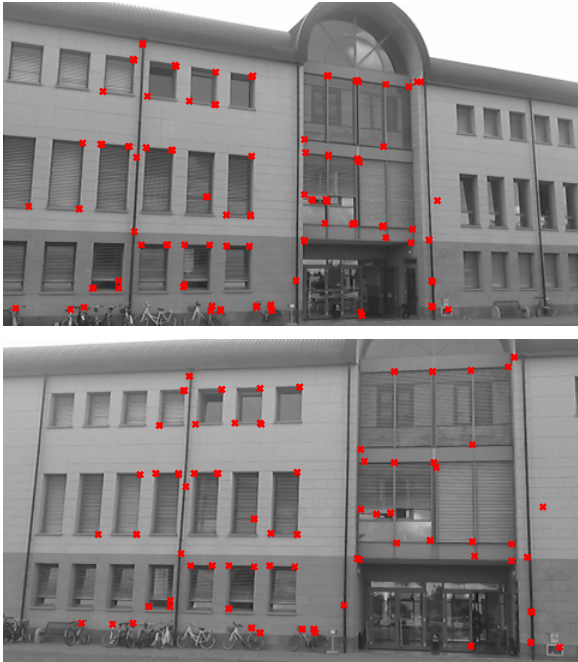
Figure 4: Example of different camera views: correctly matched features by the proposed algorithm are shown (red crosses).